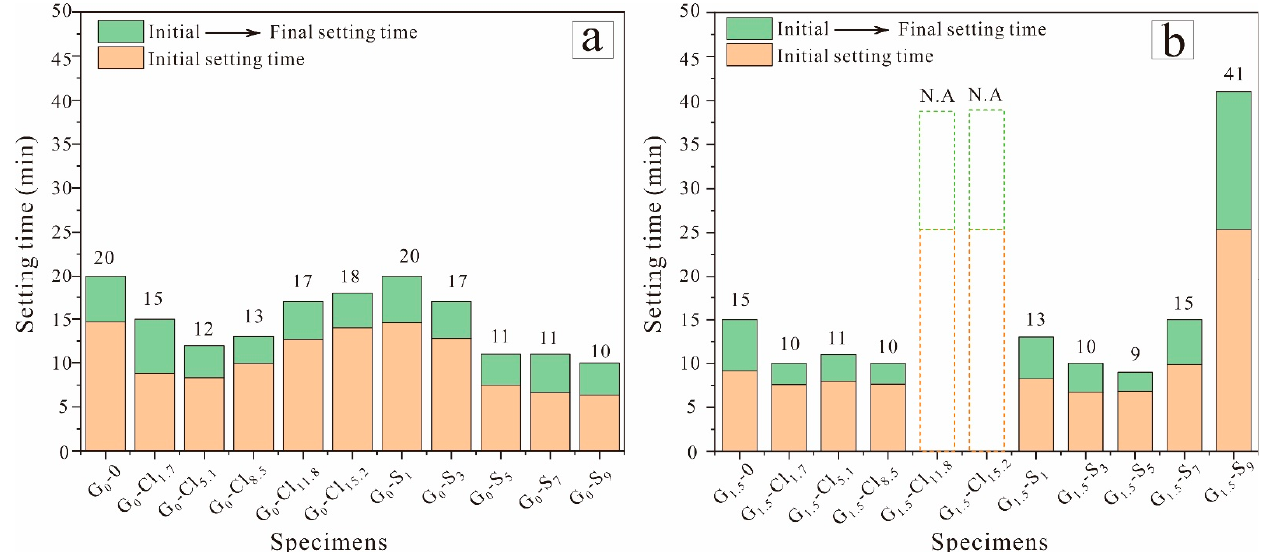
Figure 3. Setting times of ( a ) NaOH-activated and ( b ) Na 2 SiO 3 -activated geopolymers. (Dotted lines indicate specimens that could not set at ambient temperature).